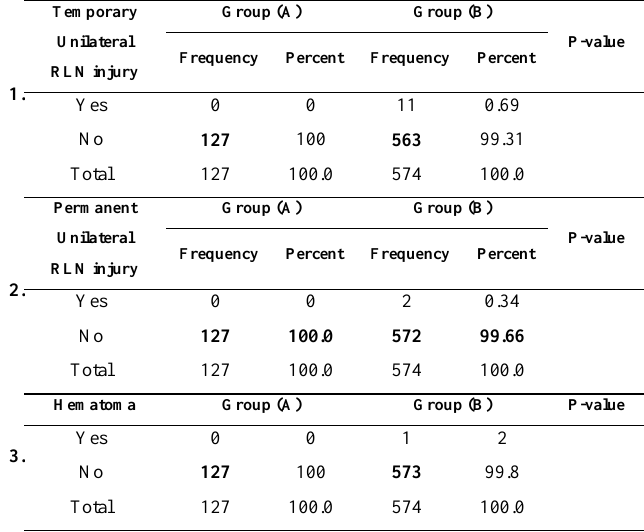
Table 3: Distribution of post-operative complications (RLN injury and tension hematoma) of the study sample: